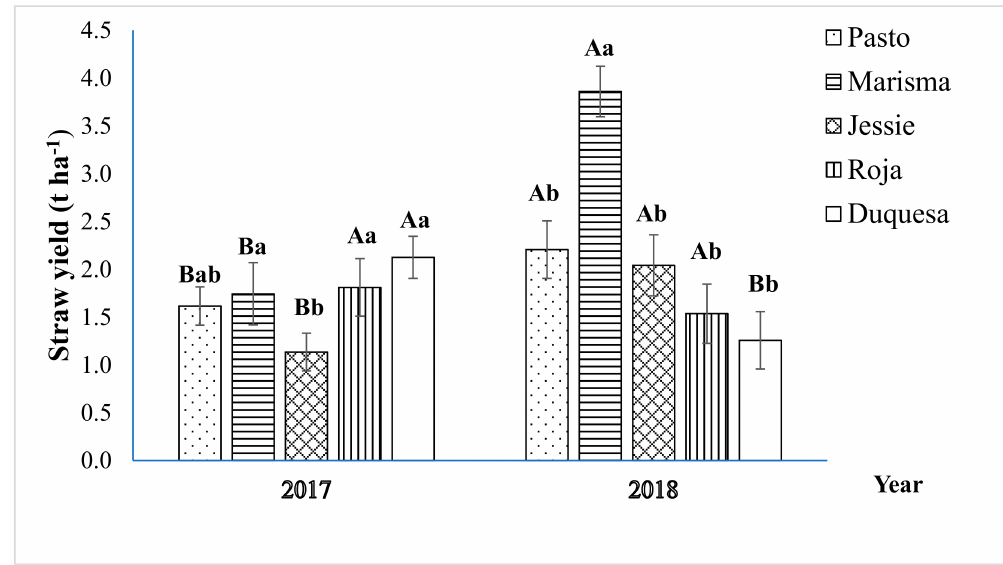
Figure 1. Straw yield (t. ha − 1 ) of five quinoa varieties during the two years (2017 and 2018) of field experiments. Error bars represents the standard deviation. Different uppercase letters in the same variety indicate a significant difference between years according to Student’s t -test at p < 0.05. In each year, different lowercase letters indicate significant differences among varieties according to Tukey’s test at p < 0.05.